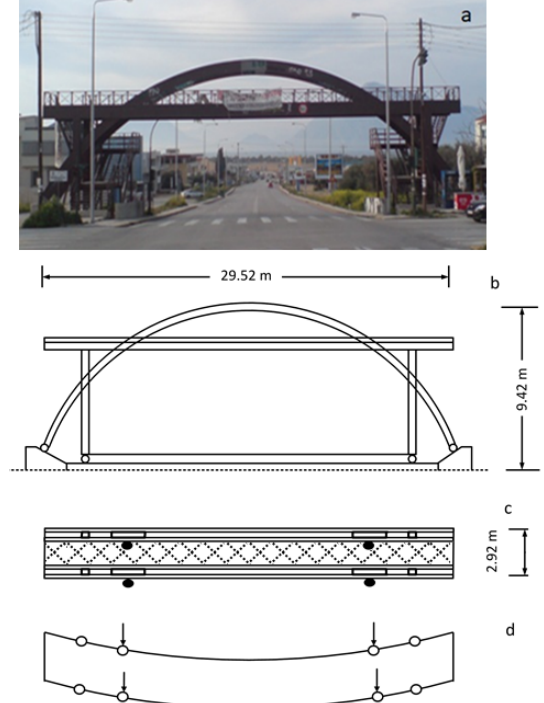
Figure 1. The Kanellopoulos timber bridge and its structural pattern. ( a ) Side view towards north; the sea is visible in the background; ( b ) Simplified vertical structural pattern. High vertical stiffness is inferred; ( c ) Simplified horizontal structural pattern. Low stiffness is readily inferred. Black dots indicate areas of asymmetric damage discussed in Figure 4. X-bracing beneath the deck, omitted in the construction, is marked by dashed x’s; ( d ) Pattern of the instantaneous deformation of the deck because of dynamic loading. Open circles indicate hinges, connections with vertical columns in ( c ) and the arch. Arrows indicate (lateral) hinge loading by the arch structure (see also Figure 5 below).